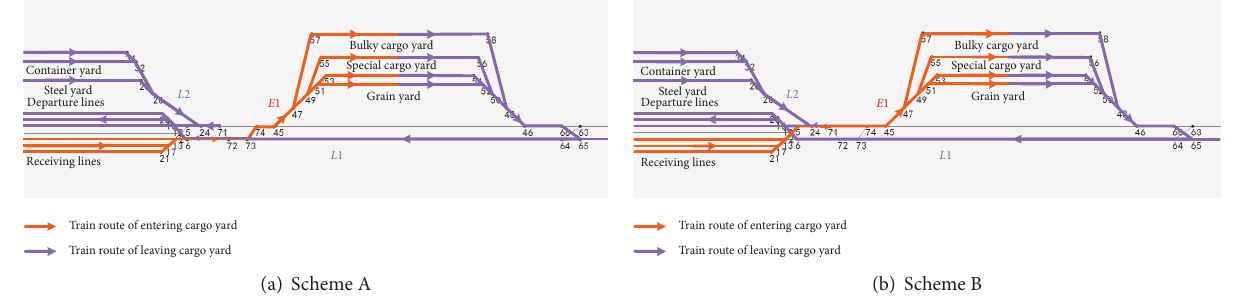
Figure 23: Two local train routes’ arrangement schemes of Qianchang railway terminal. Table 2: Performance indicators of the train moving process based on simulation tests.